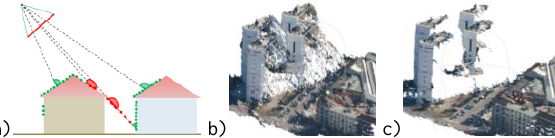
Figure 7. Schema of the mixed pixels filtering (a). Practical example of the a point cloud generated from one looking direction (b) and the filtered one after the removal of the mixed pixels (c).